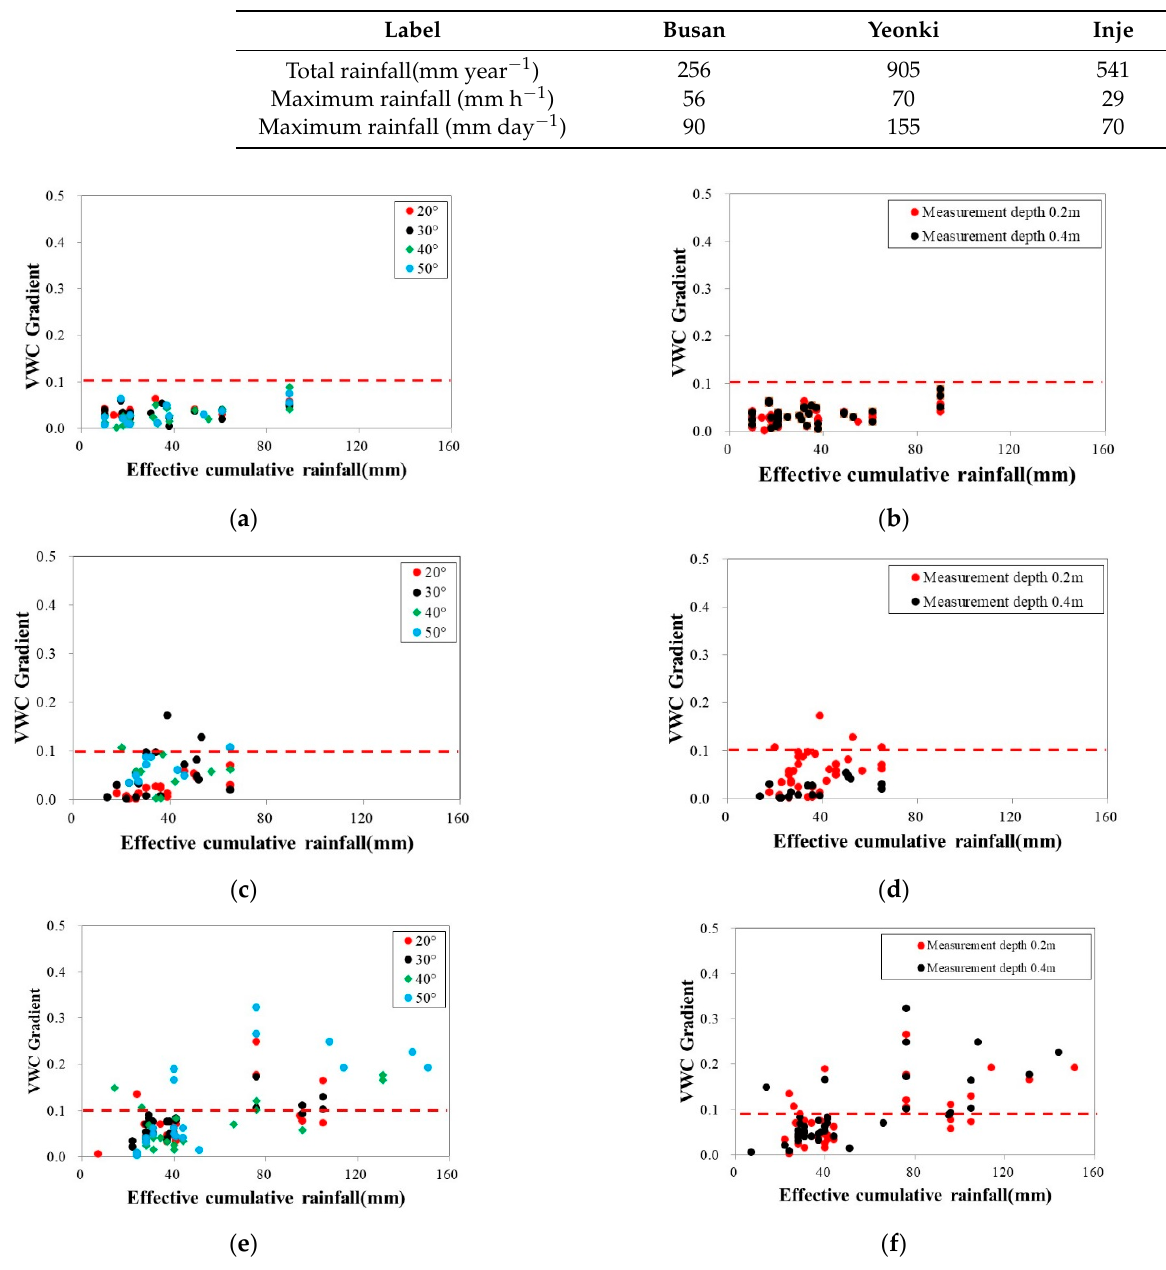
Figure 7. Plots of the VWC gradients of different testbeds: ( a ) slope angle (Busan); ( b ) measurement depth (Busan); ( c ) slope angle (Inje); ( d ) measurement depth (Inje); ( e ) slope angle (Yeonki); ( f ) measurement depth (Yeonki).